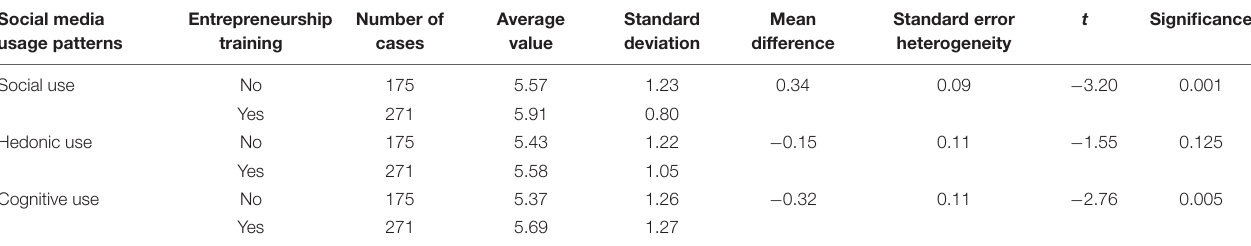
TABLE 5 | Differences in social media use patterns among those with different entrepreneurial training